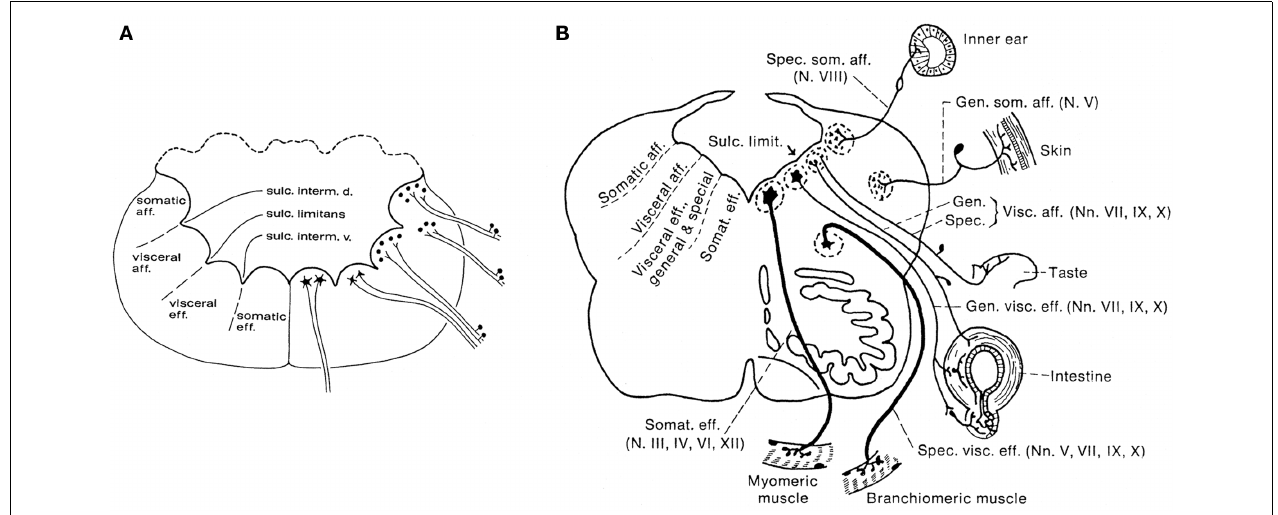
FIGURE 2 | Diagrammatic transverse sections through the rhombencephalon of an anamiote (A), and the human (B), to show the arrangement of the so-called functional columns.